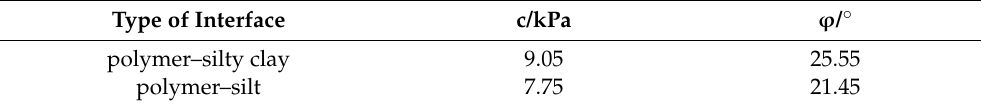
Figure 10. The shear stress–shear displacement relationship curves of the polymer–different dam materials interfaces.